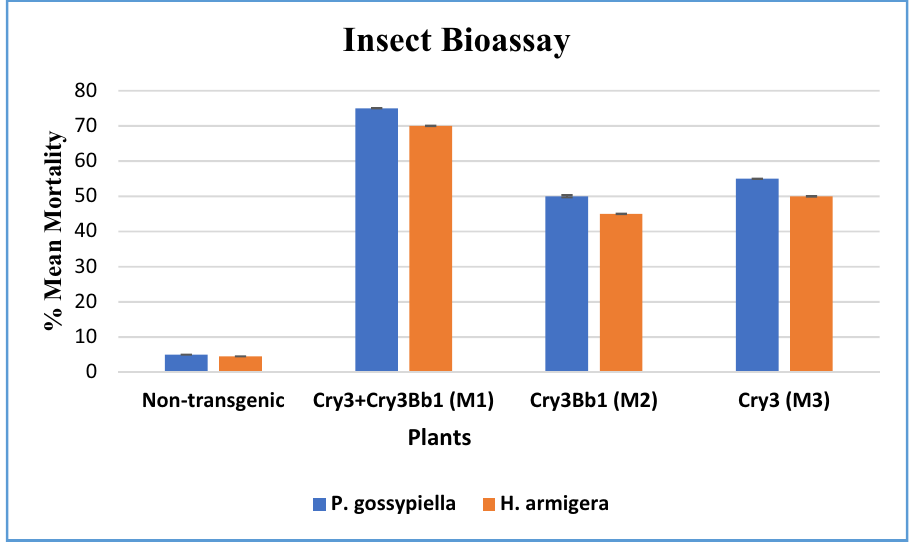
Figure 8. Mortality analysis against pink bollworm and army bollworm . Two-way ANOVA showed the significance of the data compared to the non-transformed